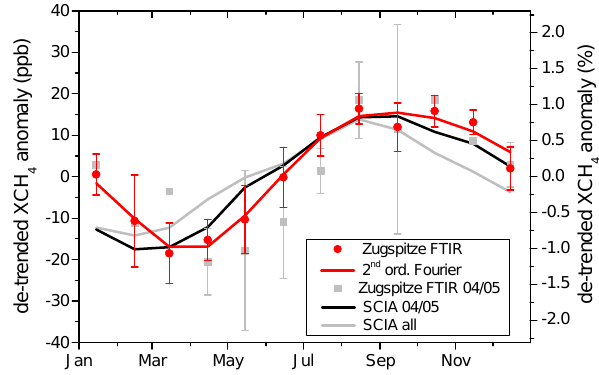
Fig. 11. Red points: multi-annual mean seasonality of column- averaged dry-air mole fractions of methane retrieved from Zugspitze FTIR. It has been derived from the de-trended monthly- mean time series in the interval [2004, 2009] with the retrieval strat- egy MIR-GBM v.1.0 (Table 10). Error bars are standard errors of the multi-annual monthly means for 95% confidence. Red line: Fit of a 2nd order Fourier series. Grey squares: Same as red points but using only [2004, 2005] FTIR data. Grey line: Seasonality de- rived from SCIAMACHY WFMDv2.0 data taken from Fig. 12 of Schneising et al. (2011) for the [2004, 2009] time interval. Black line: same as grey line but using only SCIAMACHY [2004, 2005]